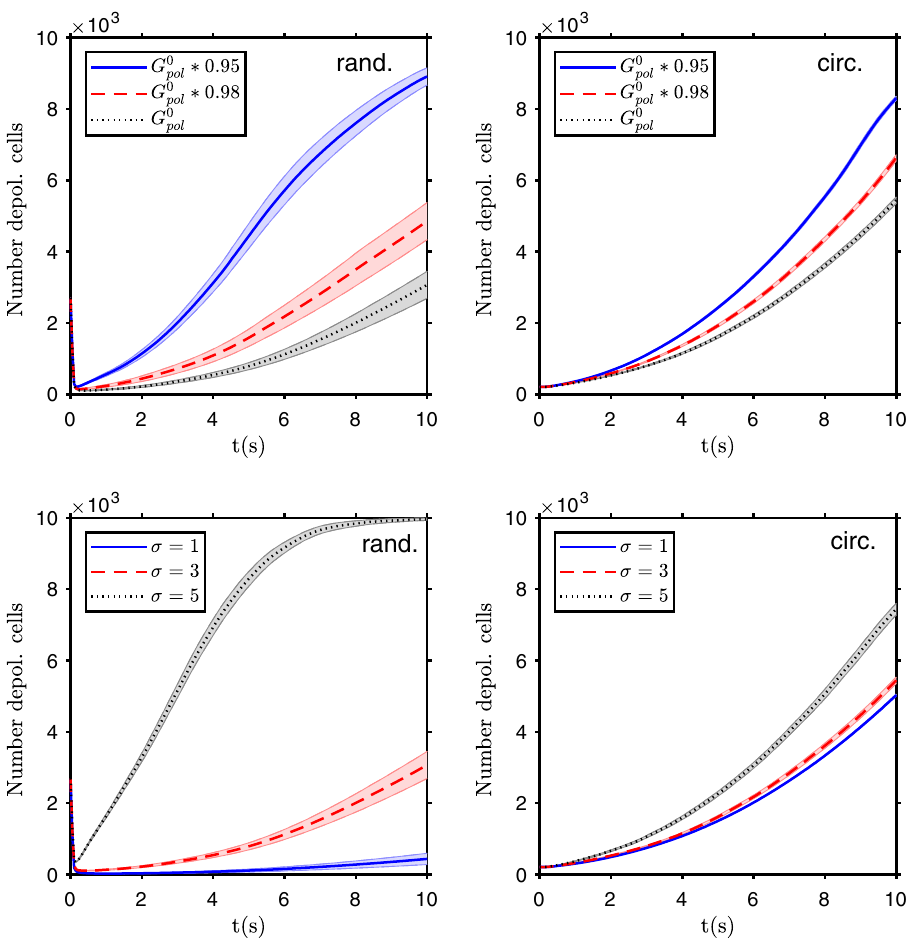
Figure 5. Parameters sensitivity tests. Top row: evolution of the number of depolarized cells for different values of the cells polarization channel conductivity G 0 pol . Bottom row: evolution of the number of depolarized cells for different values of the standard deviation σ of the cells’ bioelectric properties. The results are shown for 27% of depolarized cells randomly distributed on the domain at the start of the simulation (left column), and for an initial circular depolarization patch (with R = 8 cells’ width) at the center of the domain (right column). There is a saturation at 10 k cells, the total number of cells in the domain. The bands show the standard deviation of the mean of n = 20 simulation